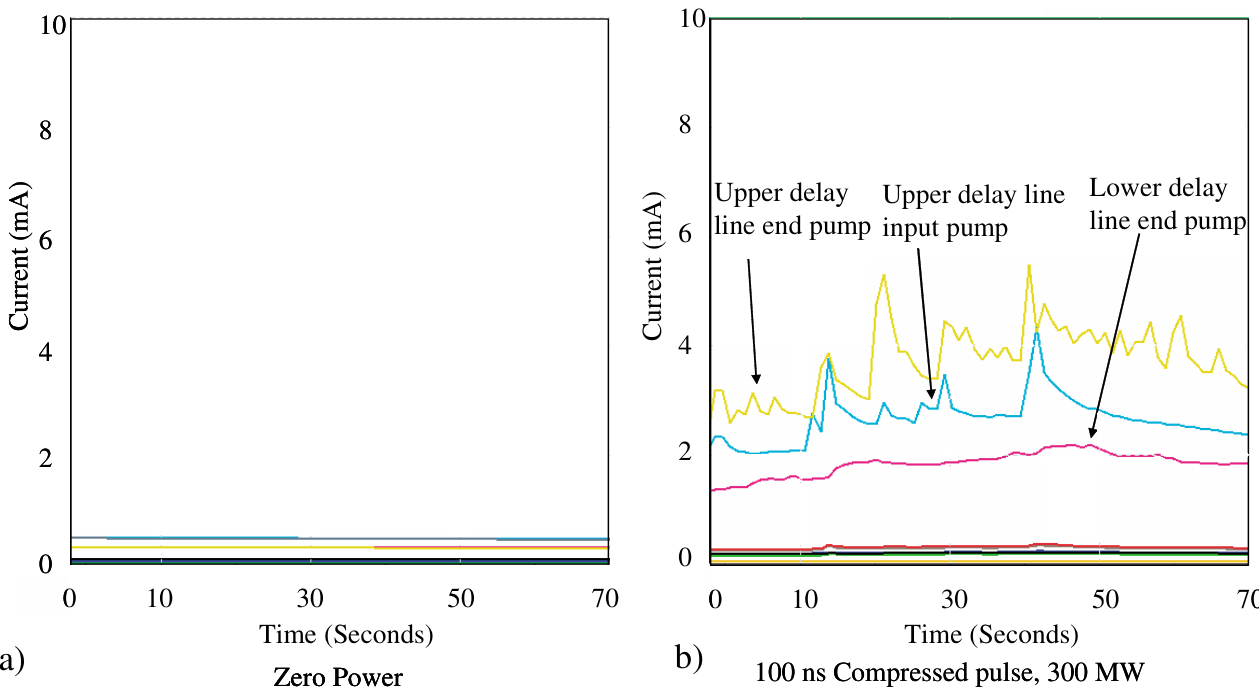
FIG. 23. (Color) Typical ion pump currents during processing (a) without and (b) with power. The figures contain traces for many ion pumps throughout the system. These typically do not show any activity. The delay lines each have an 80 liter = s pump at each end.